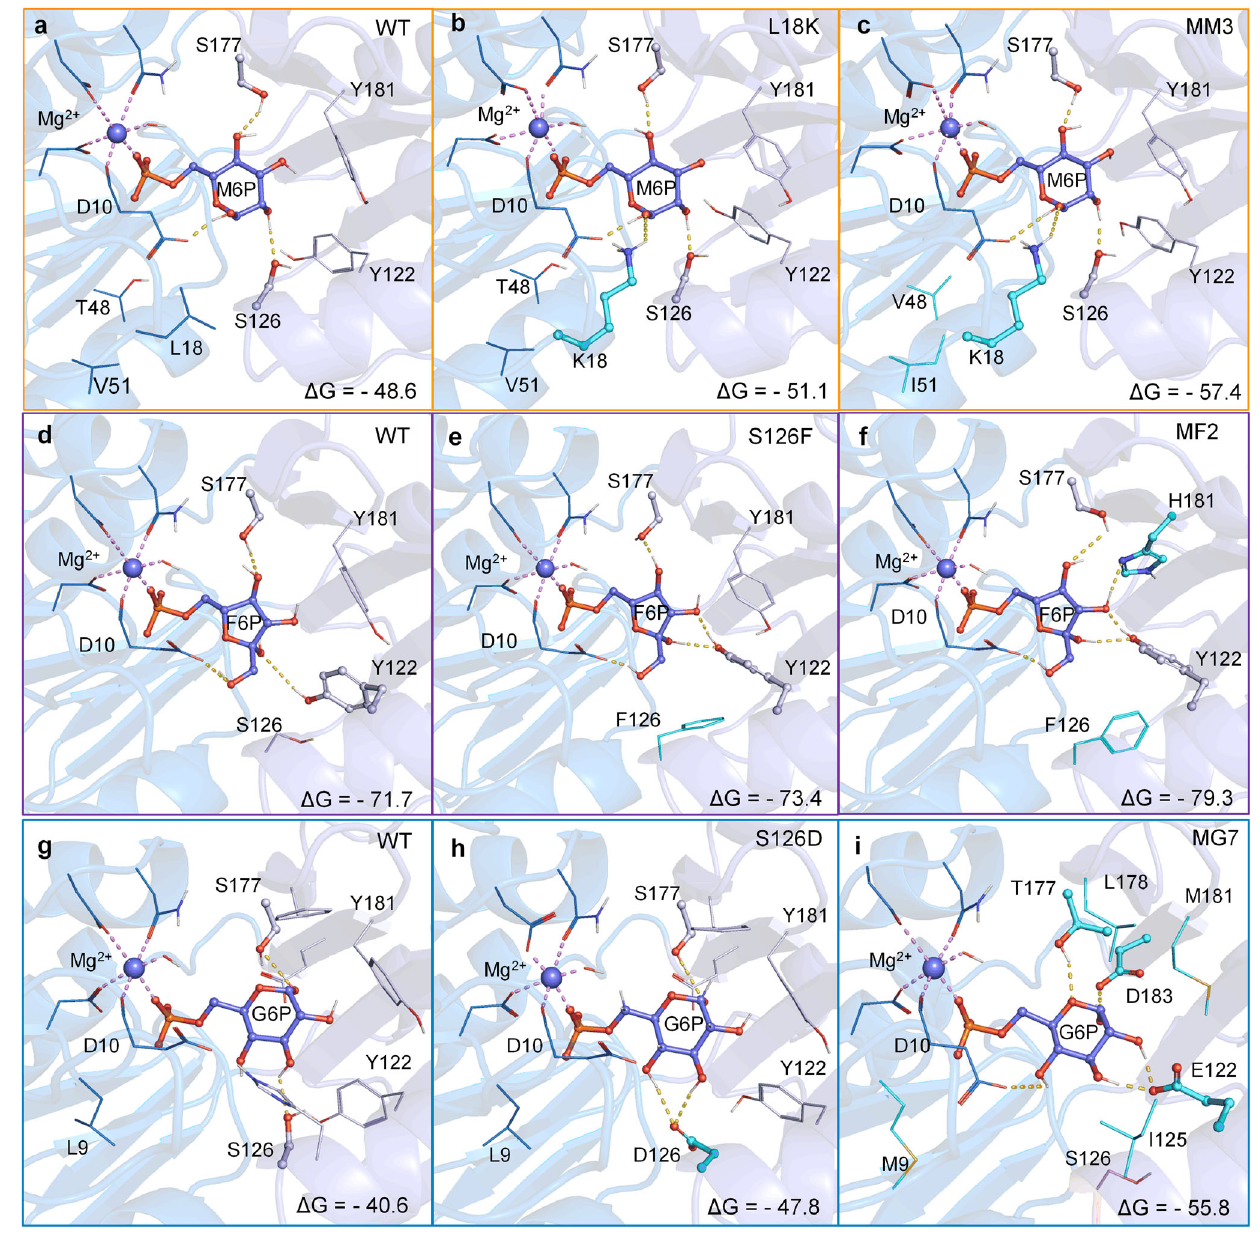
Fig. 4 The representative binding conformation and binding energy ( Δ G°) of the WT and mutants to M6P, F6P, and G6P. a – c represented that of WT, L18K and MM3 for M6P, respectively; d – f represented that of WT, S126F and MF2 for F6P, respectively; g – i represented that of WT, S126D and MG7 for G6P,